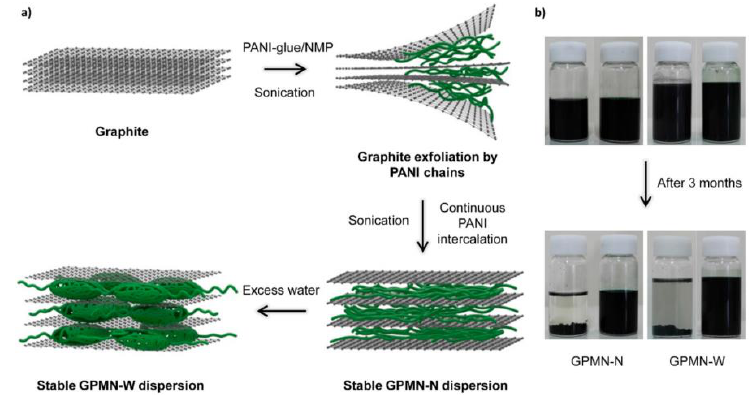
Figure 13. ( a ) Schematic illustration of the formation of graphene/PANI multilayered nanostructures (GPMNs) by direct physical exfoliation of graphite with PANI glue; ( b ) photographs showing the long-term colloidal stability of a GPMN dispersion solution in the absence ( left ) and presence ( right ) of PANI glue. GPMNs showed outstanding colloidal stability in both NMP and water. Reprinted with permission from [126]. Copyright 2015, John Wiley & Sons.